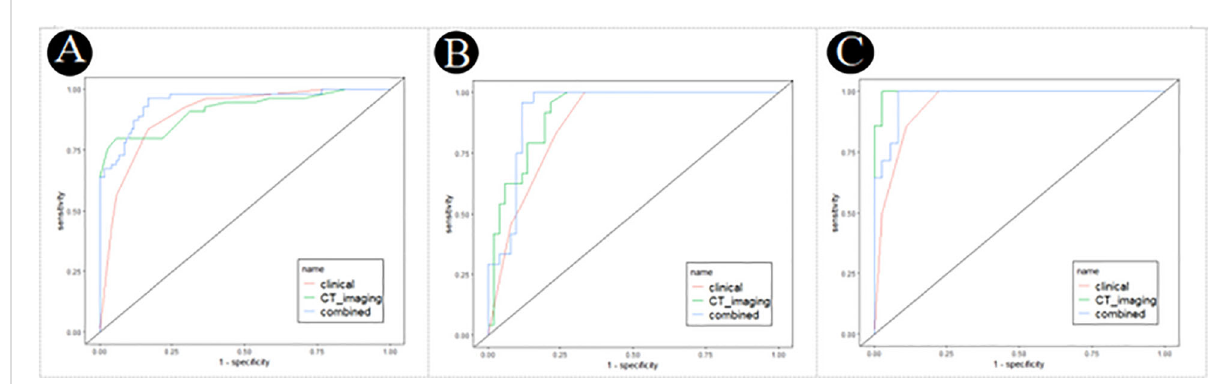
FIGURE 4 Receiver operating characteristic (ROC) curves of the clinical, CT imaging and combined model for PM-SCLC in three cohorts. (A) The training cohort. (B) The internal validation cohort. (C) The external validation